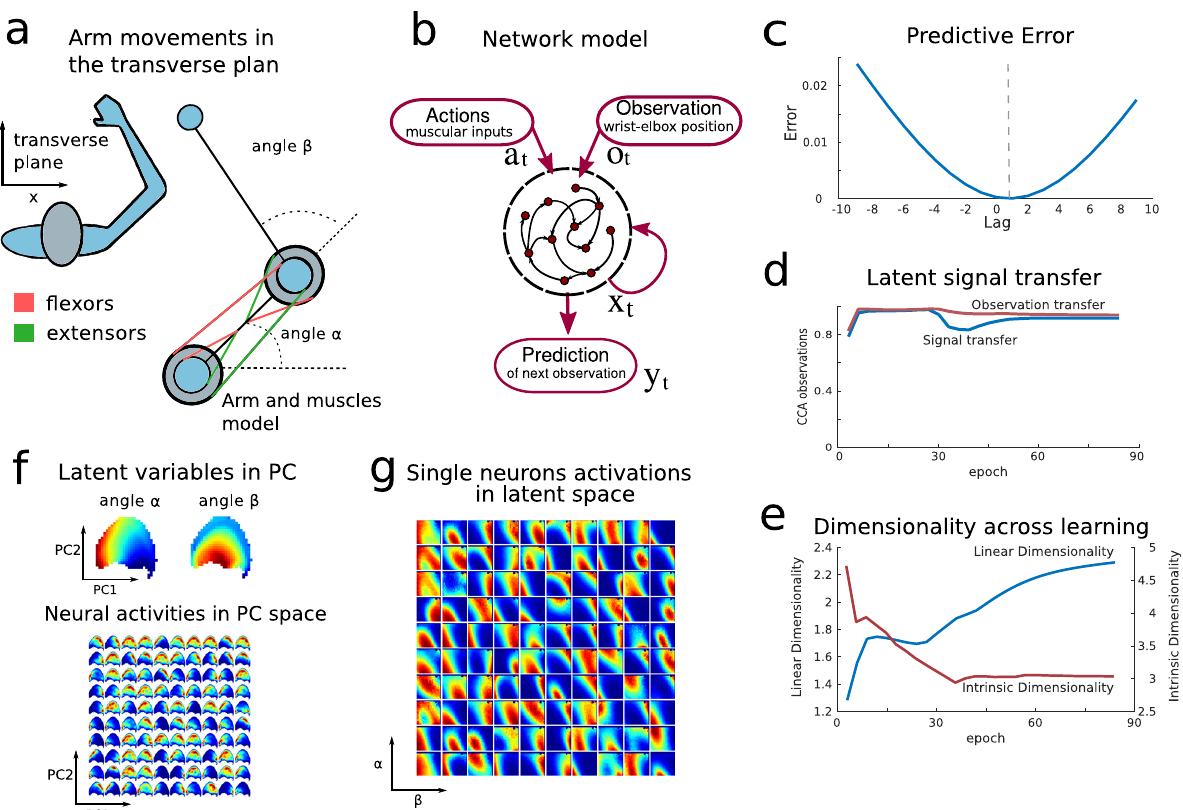
Fig. 6 Predictive representations of arm-reaching movements. a Plane transverse to the dynamic of arm-reaching movements. The muscle model is shown and the two latent angular variables α and β . b Recurrent network model. c Predictive error upon training. The symmetry axis is around lag + 1 indicating that the network is carrying out the prediction correctly. d Latent signal transfer and observation signal transfer. e Dimensionality trends across learning for both linear (PR) and nonlinear (ID) dimensionality measures. f Top: principal components space (PCs 1 – 2) colored by the average angles α , β for each location. Bottom: average activity of neurons in the space spanned by the top 2 PCs. Each subplot represents the average activity of a single neurons. Neurons are ranked according to their average fi ring rates. The most active neuron is in the top left corner, the second in the fi rst column second row and so on for all the neurons. g Average activity of neurons in latent space α , β . Each subplot corresponds to the neuron in panel f